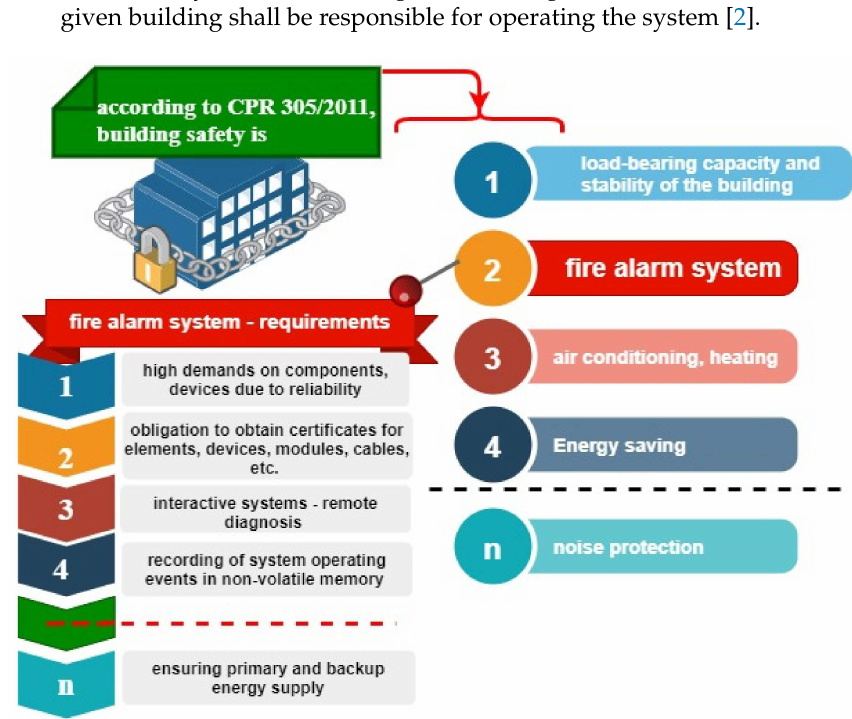
Figure 1. Requirements in the field of FAS application in buildings pursuant to CPR